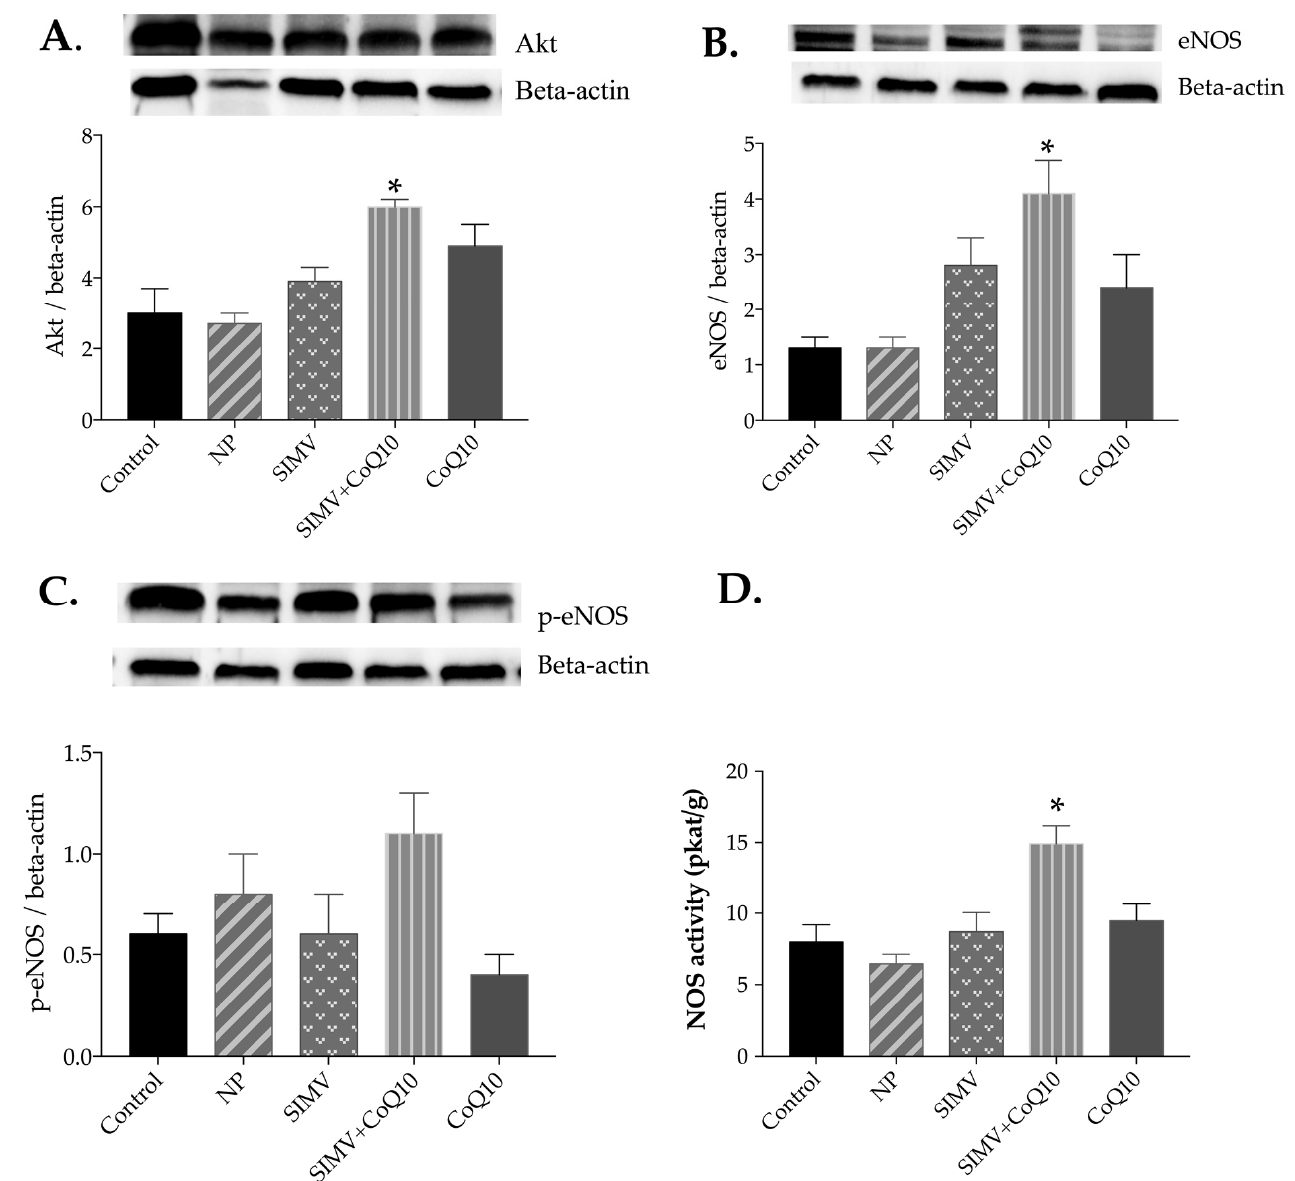
Figure 3. Expression levels and representative Western blot images of Akt ( A ), endothelial nitric oxide synthase (eNOS) ( B ), phosphorylated eNOS (p-eNOS) ( C ), and total NOS activity ( D ) in the aorta of the control group and groups treated with empty nanoparticles (NP), simvastatin-loaded nanoparticles (SIMV), combination of simvastatin-loaded and coenzyme-Q10-loaded nanoparticles (SIMV+CoQ10), and coenzyme-Q10-loaded nanoparticles (CoQ10). * p < 0.01 compared to the control obese Zucker rats. Data are means ± SEM from 6 animals in each group.